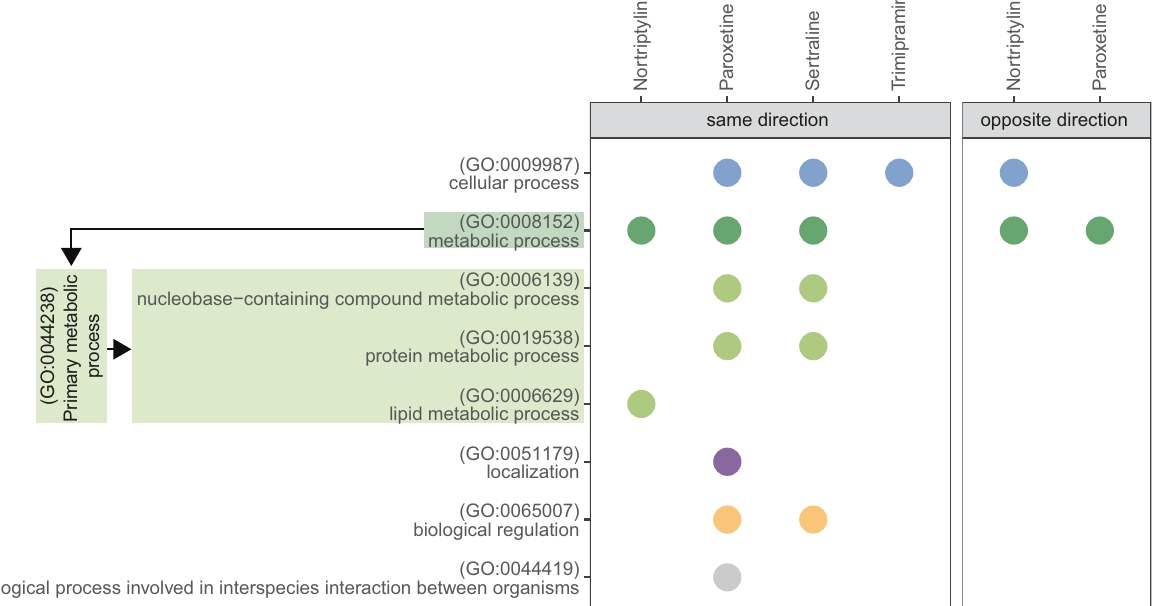
Fig. 2 Biological processes identi fi ed among genes perturbed by statins and antidepressants in NPC cells. Biological processes identi fi ed amongst genes perturbed in the same (left panel) and opposite (right panel) directions by statins and antidepressants are shown. Y -axis shows the ancestor GO biological process terms, as well as the child terms of primary metabolic process (GO:0044238) (a child term of “ metabolic process ” ). Arrows indicate ancestor-to-child relationships between GO terms. The bubble plots show the antidepressants for which the biological processes were identi fi ed as signi fi cantly enriched (gSCS-corrected p -value < 0.05) in at least one statin-antidepressant